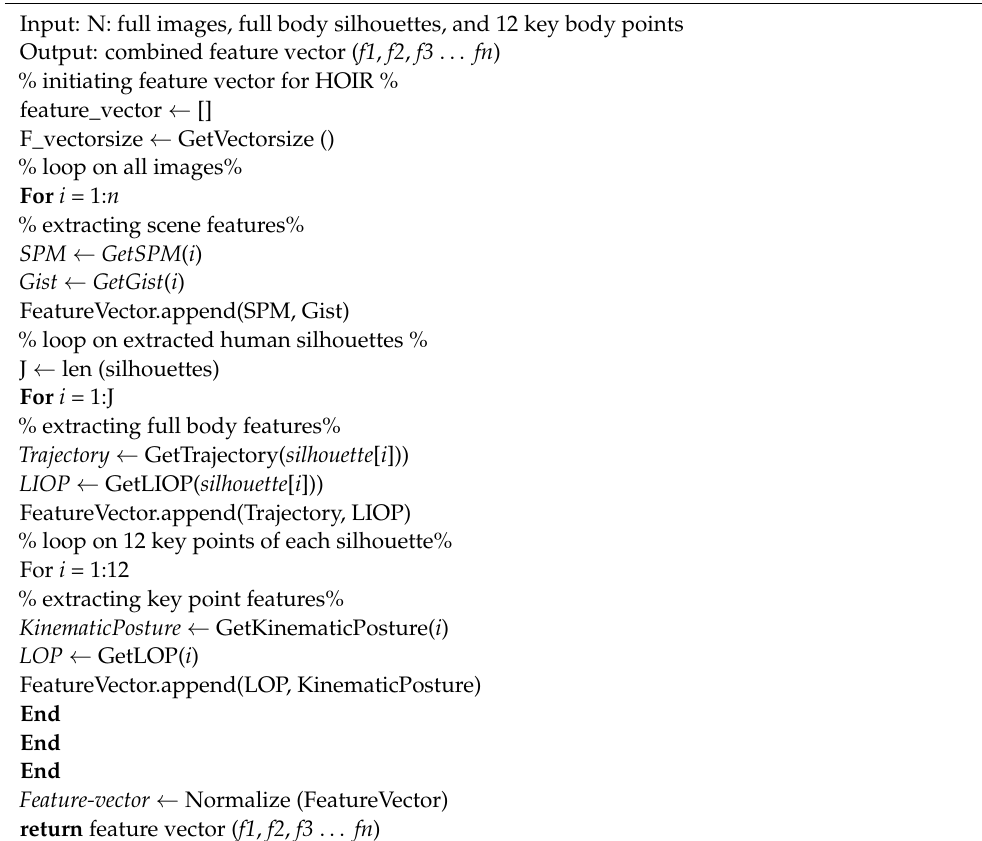
Algorithm 1: Feature Extraction